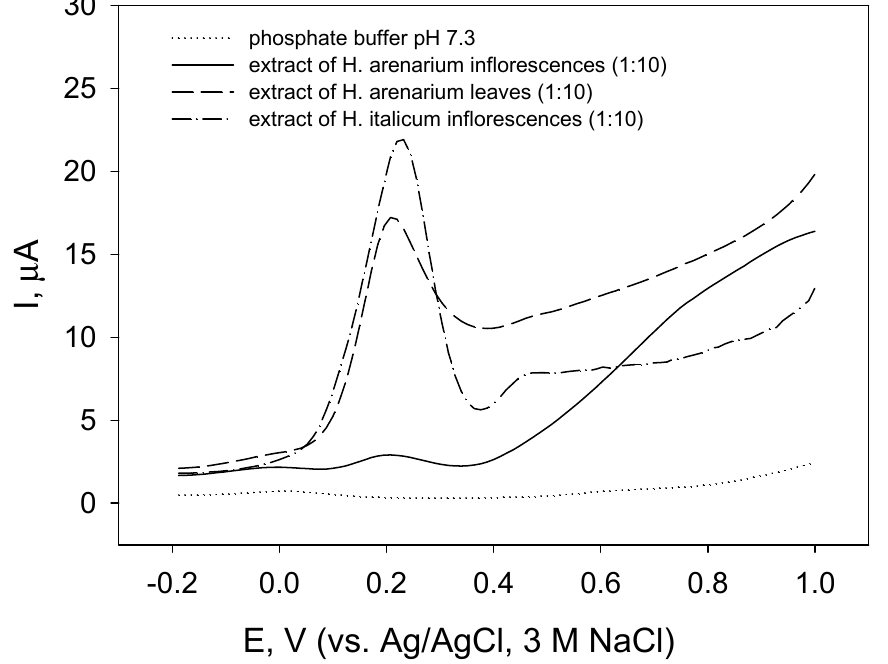
Figure 2. Square wave voltammograms of carbon paste electrode in extracts of inflorescences and leaves of H. arenarium and inflorescences of H. italicum (as indicated) in phosphate buffer pH 7.3; potential step 4 mV, amplitude 50 mV, frequency 25 Hz.